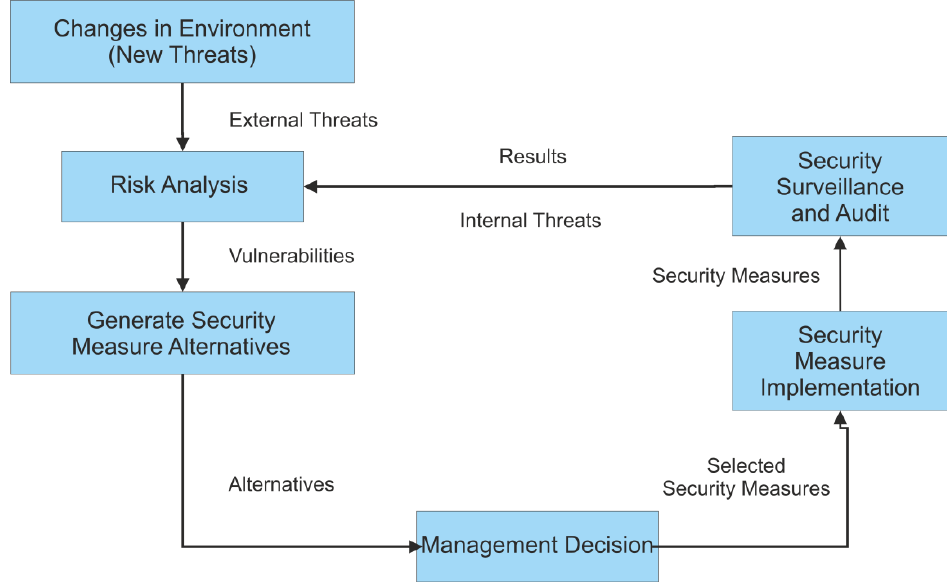
Figure 1. The Risk Management Life Cycle